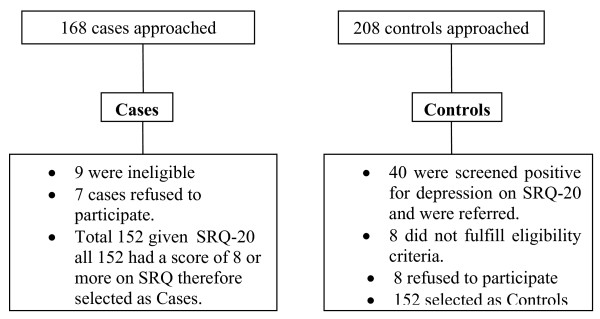
Study participants.